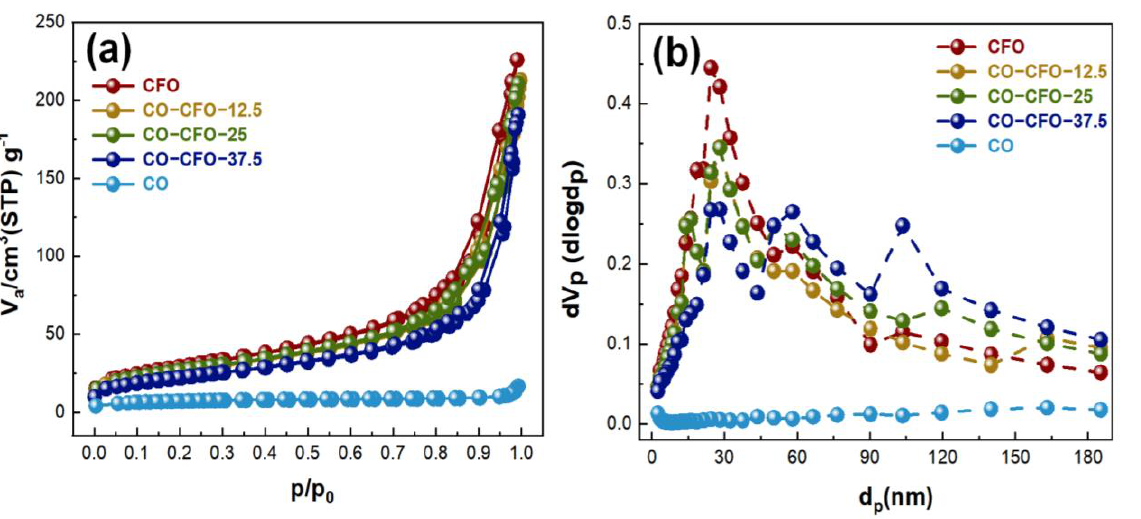
Figure 4. ( a ) Nitrogen adsorption-desorption isotherms of CFO, CO-CFO-X, and CO ( b ) Barrett–Joyner–Halenda (BJH) pore size distribution. Table 1. The comparison of SSAs, pore volume, and average pore diameter of CFO, CO-CFO-X, CO.